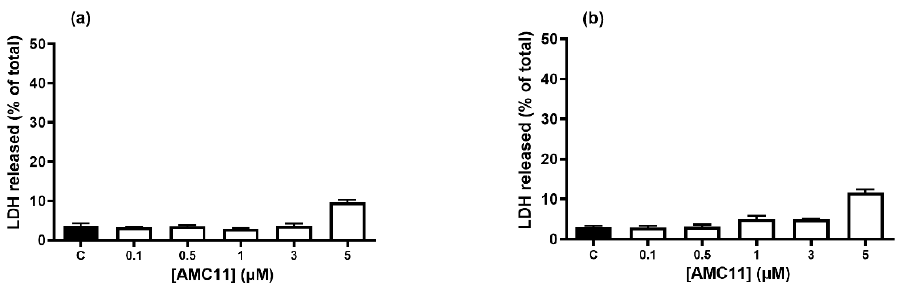
Figure 2. AMC11 toxicity on human prostate cancer cell lines. ( a ) LNCaP and ( b ) PC3 prostate cancer cells were exposed to increasing AMC11 concentrations ranging from 0.1 to 5 µ M for 72 h. Then, the percentage of LDH release was determined as an index of cell death. Data represent mean ± SEM of 8 to 12 determinations.